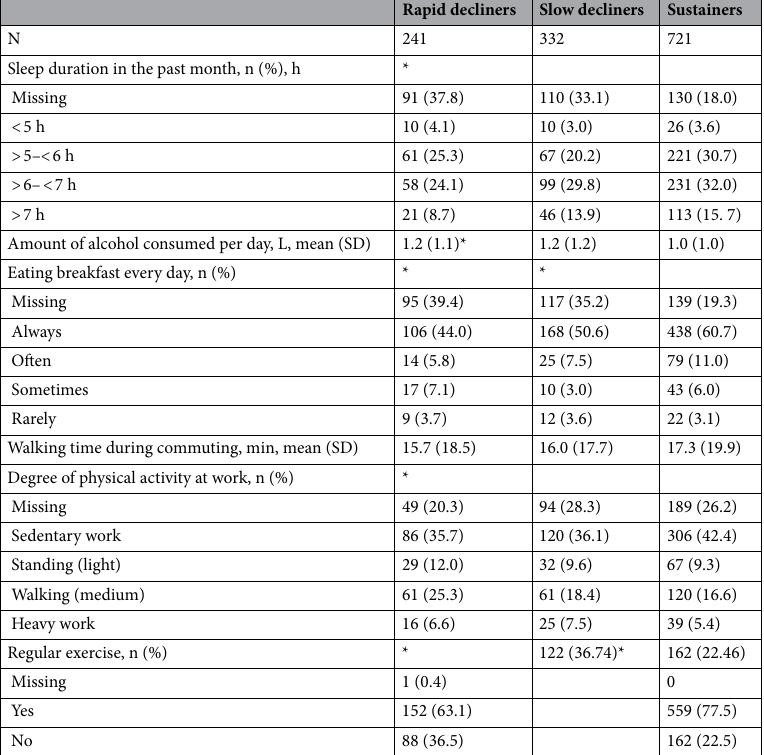
Table 2. Questionnaire-related outcomes. *Statistically significant difference vs sustainers at < 0.05. N subjects, SD standard deviation.